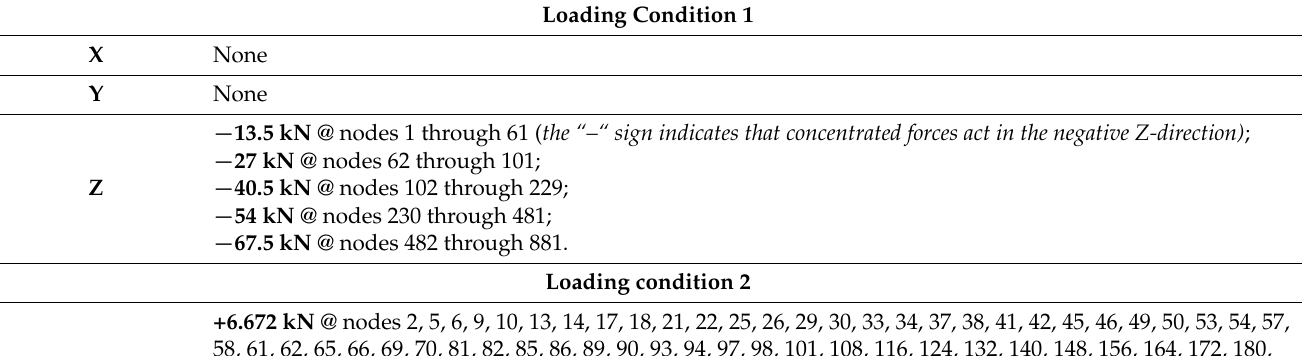
Table 5. Loading conditions acting on the 3586-bar tower. Loading Condition